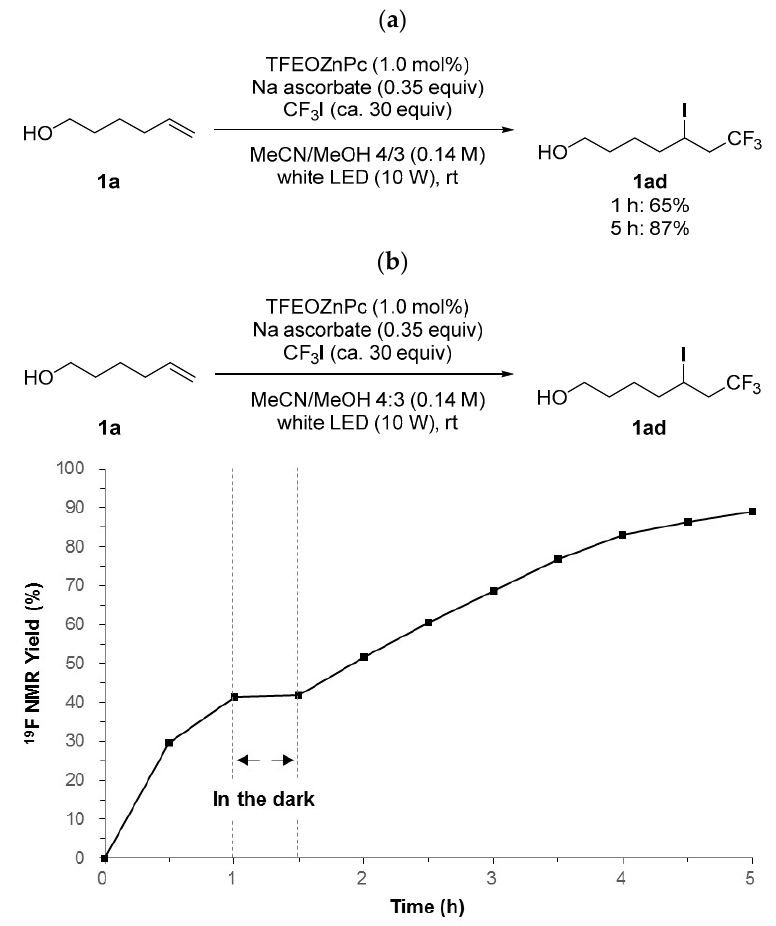
Figure 2. The time profile and light/dark experiment on trifluoromethylation of 1a with TFEO-ZnPc under visible light irradiation: ( a ) Trifluoromethylation of 1a with TFEO-ZnPc under optimized conditions for a reaction time of 1 h and 5 h; ( b ) Time profile and light/dark experiment on trifluoromethylation of 1a with TFEO-ZnPc.